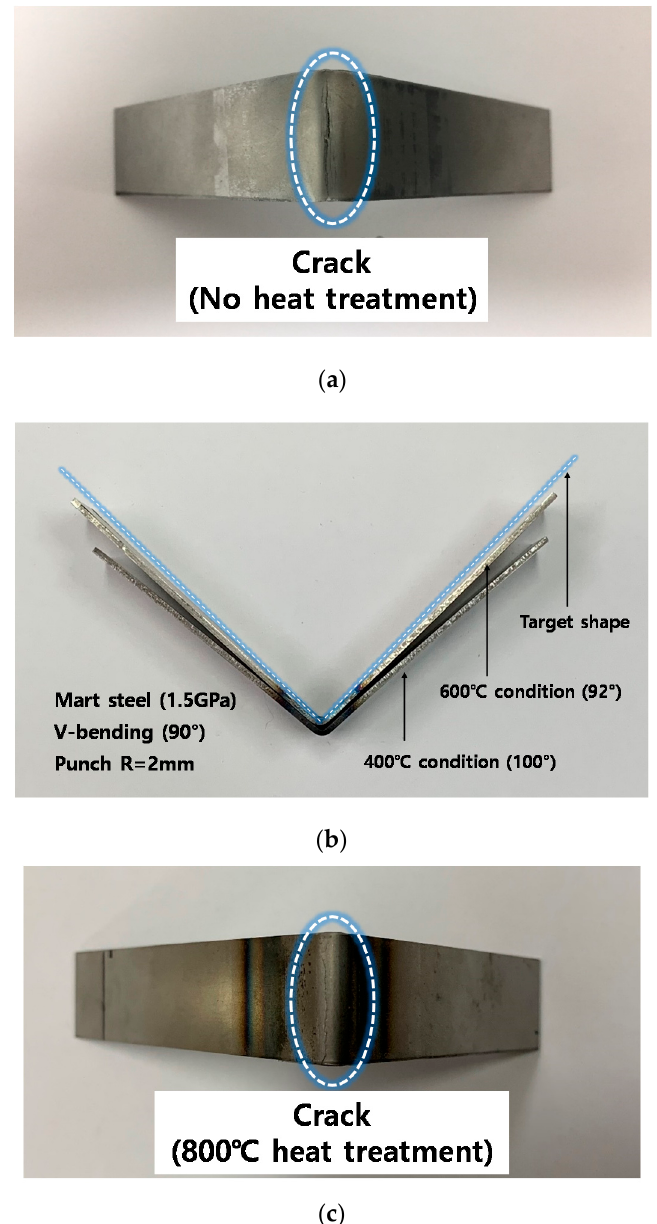
Figure 5. V-bending results: ( a ) Crack on the non-heat-treated specimen; ( b ) Bent angle; ( c ) Crack on the 800 °C-treated specimen. Table 2. Results of the V-bending.